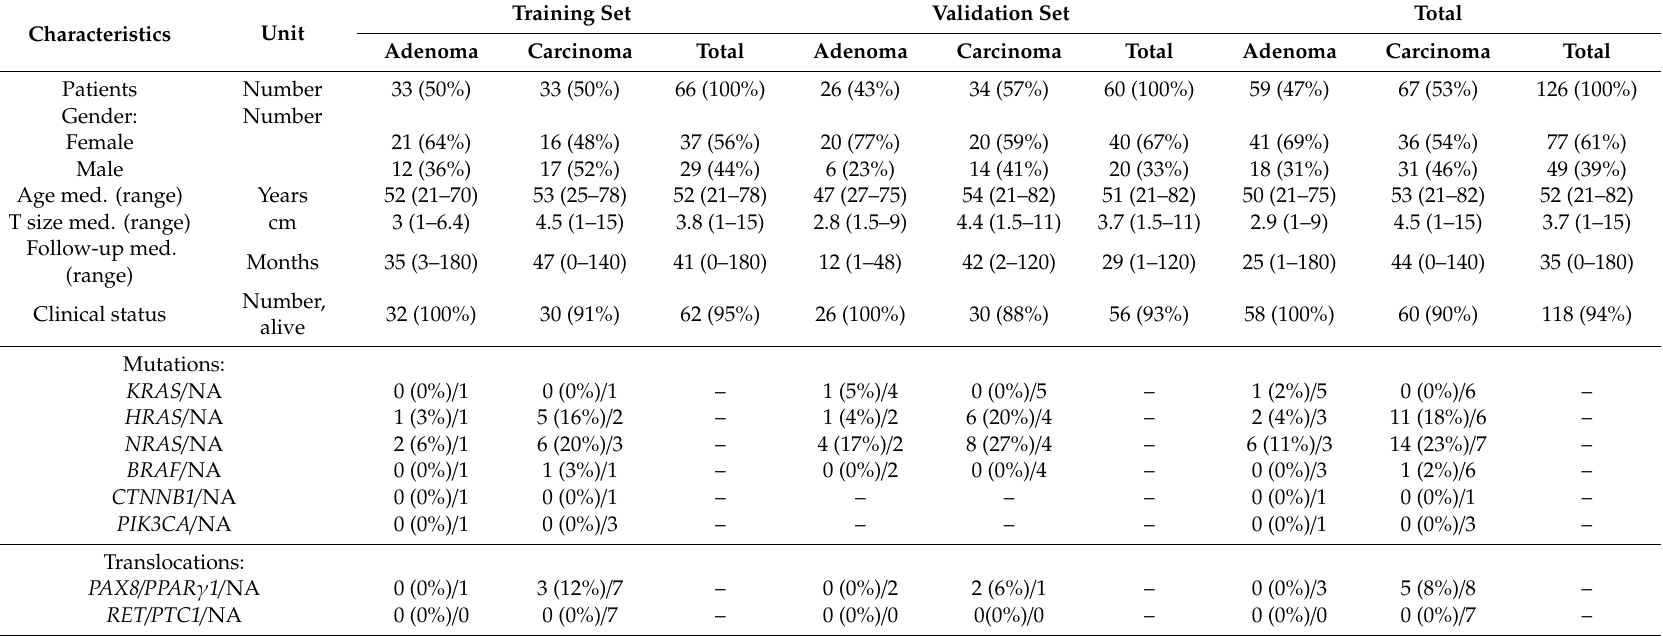
Table 1. Clinicopathological and biological characteristics of the 126 patients with follicular thyroid neoplasms (training and validation sets).